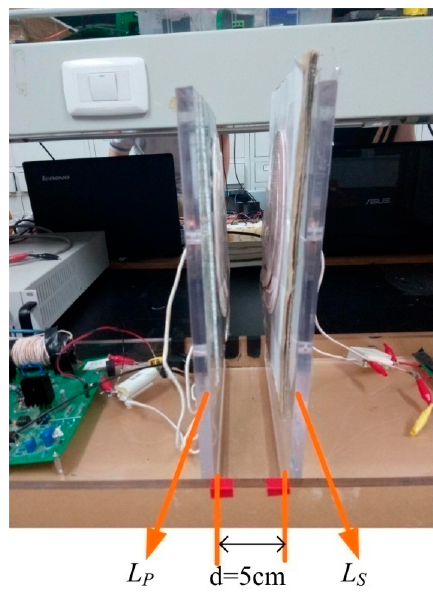
Figure 16. Photo of the prototype.